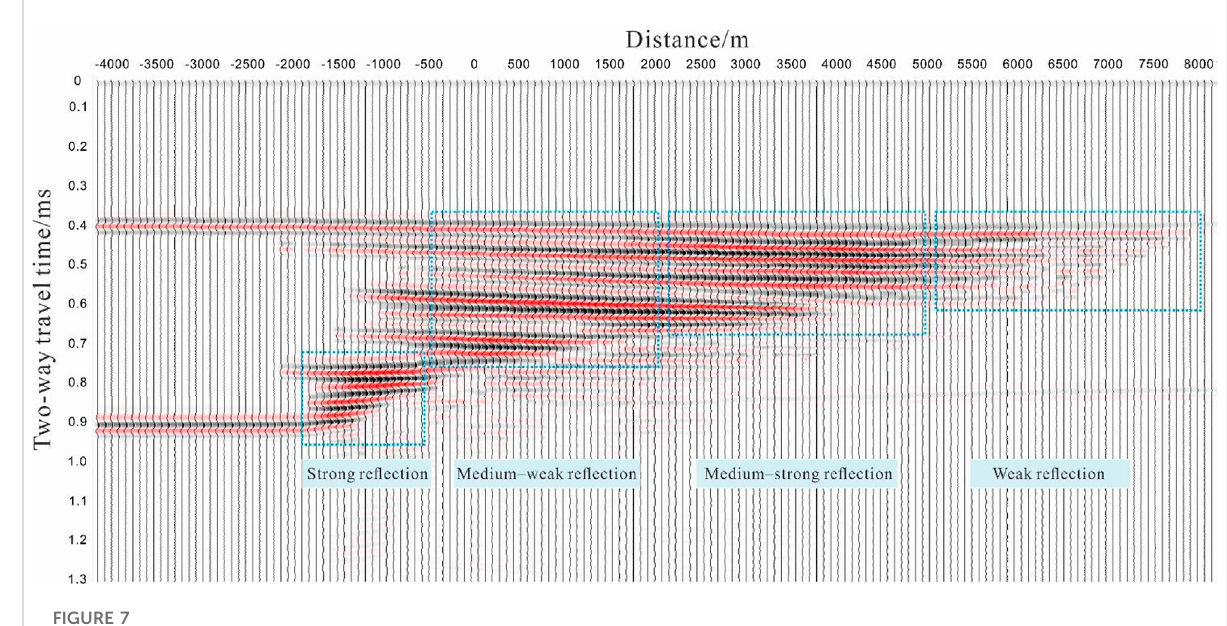
FIGURE 7 Pre-stack Kirchhoff time-migration pro fi le of the geologic model of the Miocene reservoir in the Aketao structural